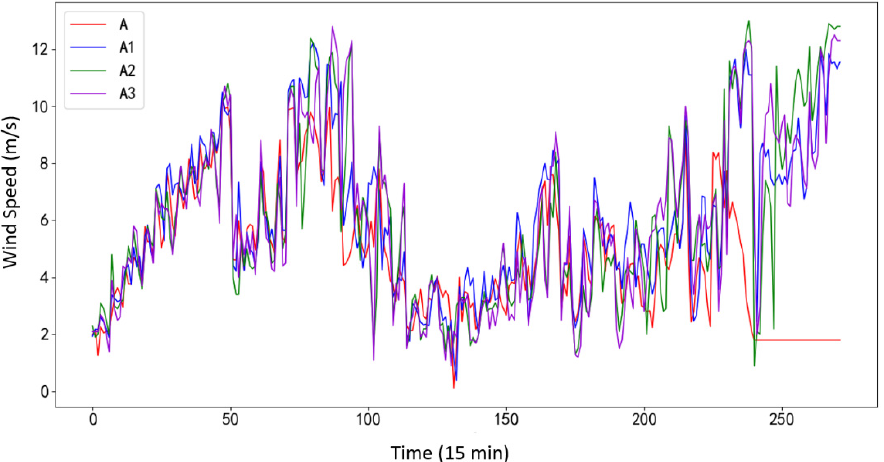
Figure 5. The SCADA wind speed (72 h) change sequence diagram of the four selected wind turbines in the northern Inner Mongolia wind farm (cf. Figure 11).